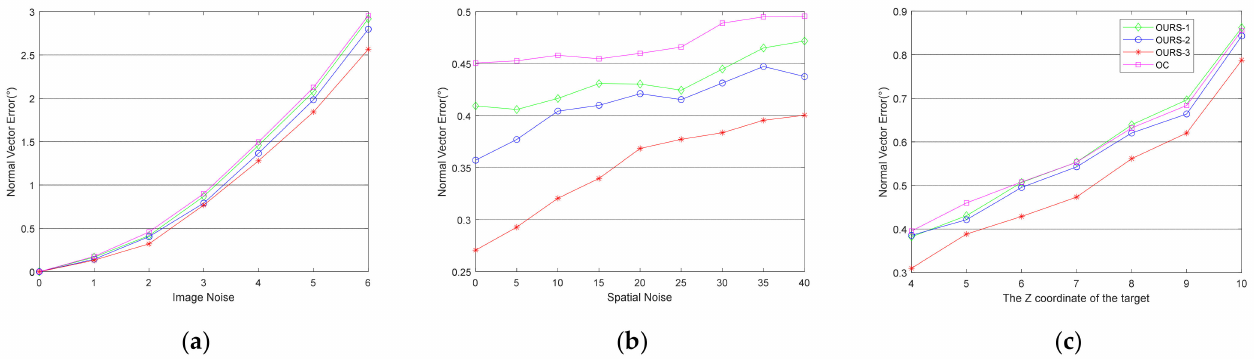
Figure 4. This is a figure about the angle error of the normal vector under different simulation conditions. The normal vector that only eliminates duality by O 1 and O 2 is marked as OC, and the normal vectors solved by the fusion algorithm with O 1 , O 2 and both O 1 and O 2 are marked as OURS-1, OURS-2, and OURS-3, respectively. ( a ) The angle error of the normal vector under different levels of noise in image features; ( b ) The angle error of the normal vector under different levels of noise in the spatial structure; ( c ) The angle error of the normal vector under different z -axis coordinates of the